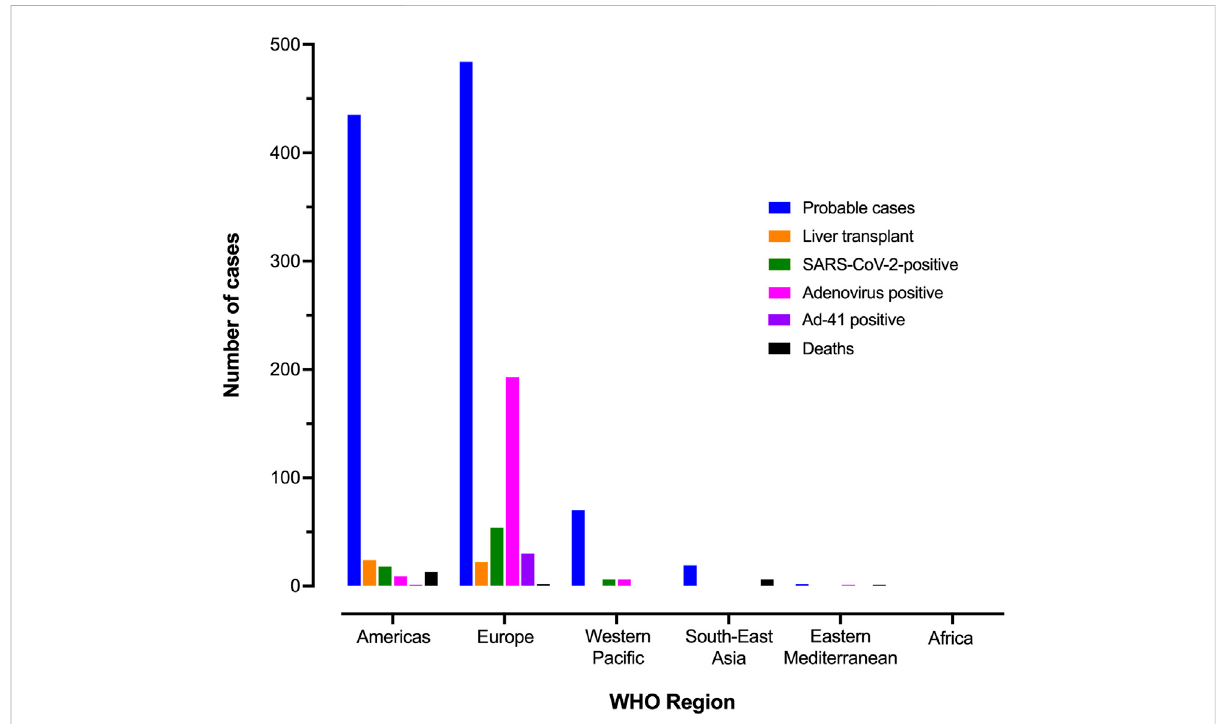
FIGURE 3 Region of origin of AS-Hep-UA cases and outcomes. Data collected by TESSy for 513 cases of AS-Hep-UA from 21 different countries (Joint ECDC-WHO Regional Of fi ce for Europe Hepatitis of Unknown Origin in Children Surveillance